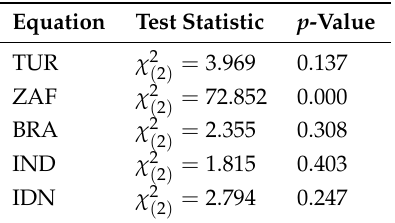
Table 5. Jarque–Bera